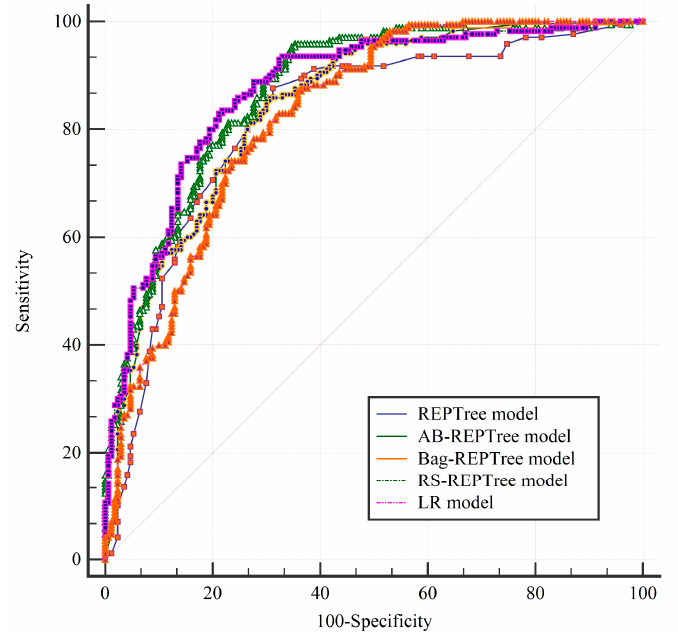
Figure 7. ROC curves related to the susceptibility models used in this study. 403